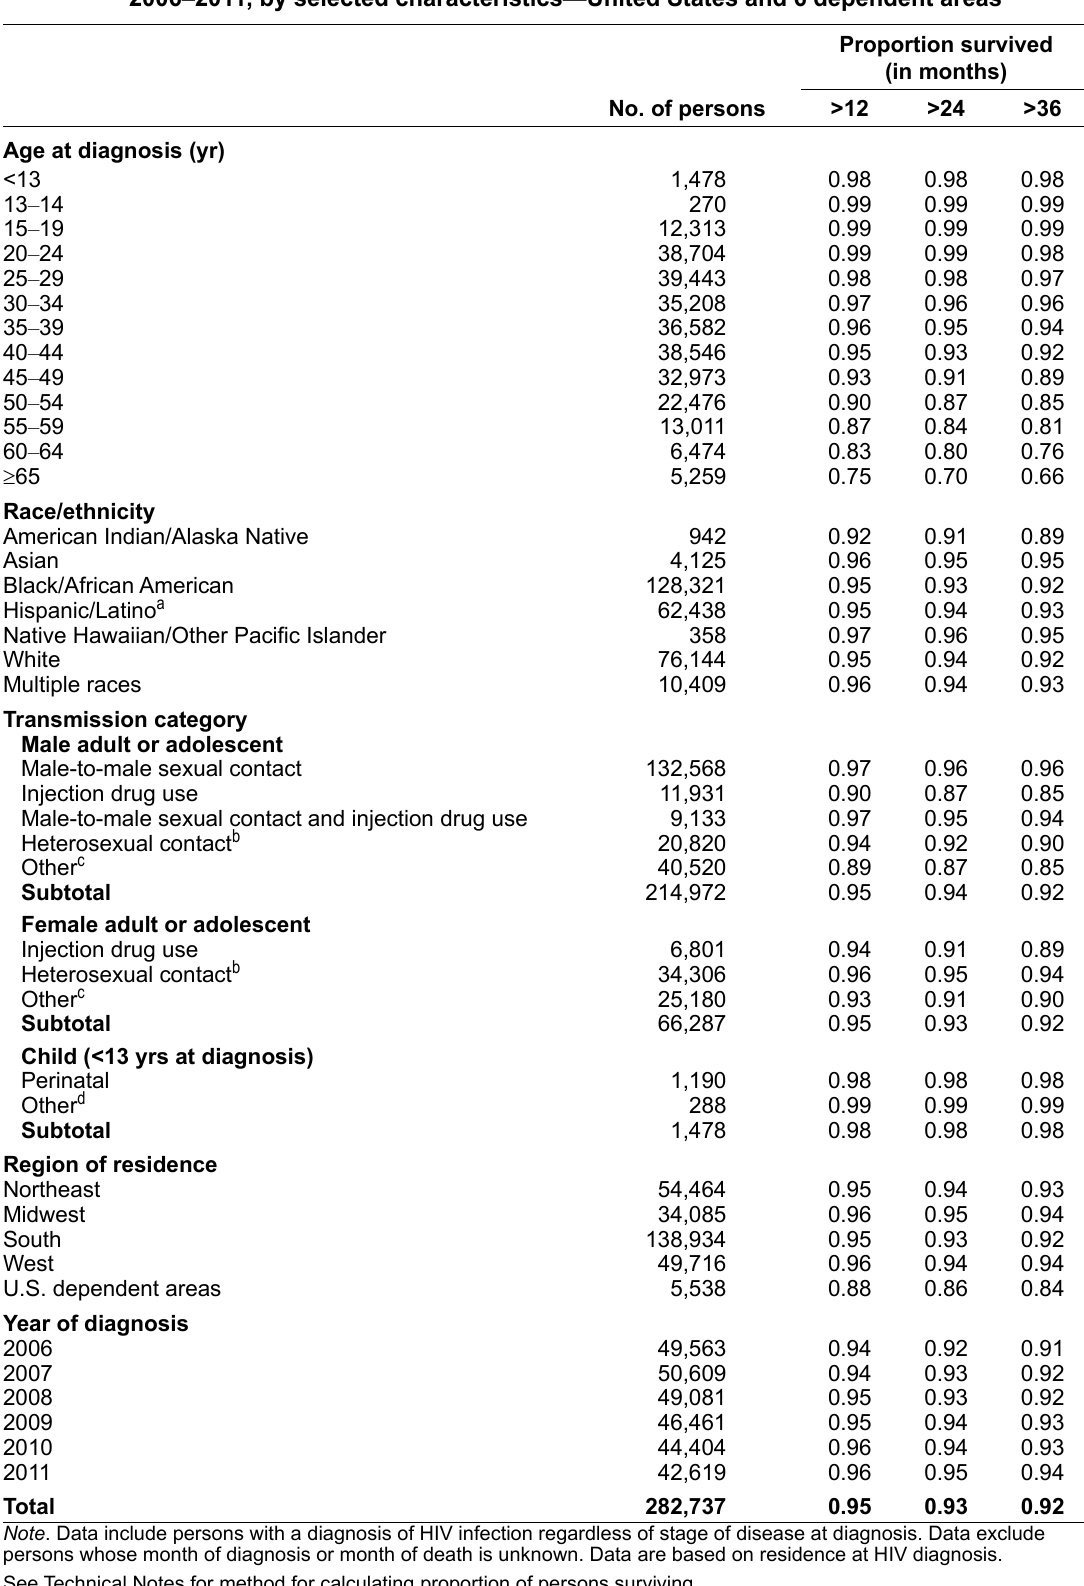
Table 16b. Survival for more than 12, 24, and 36 months after a diagnosis of HIV infection during 2006–2011, by selected characteristics—United States and 6 dependent